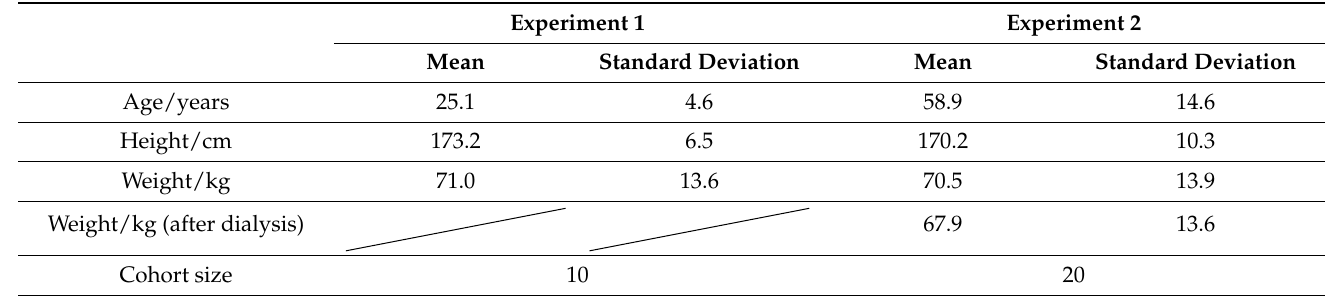
Table 1. Summary of demographic information of subjects that participated in